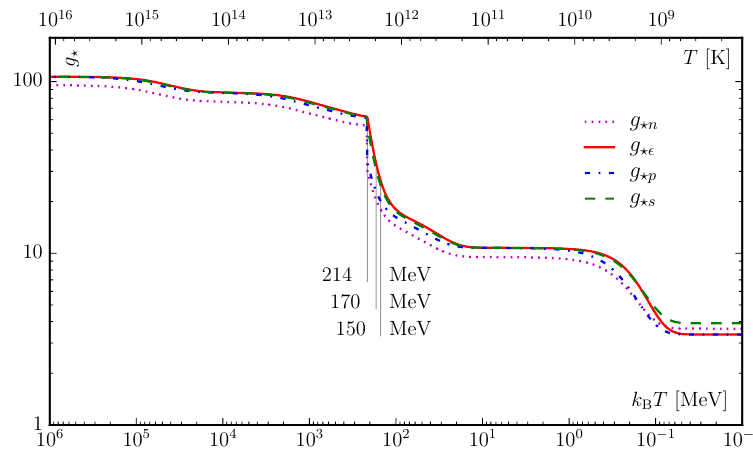
Figure 1. The evolution of the number density ( g ⋆ n ), energy density ( g ⋆ (cid:101) ), pressure ( g ⋆ p ), and entropy density ( g ⋆ s ) as functions of